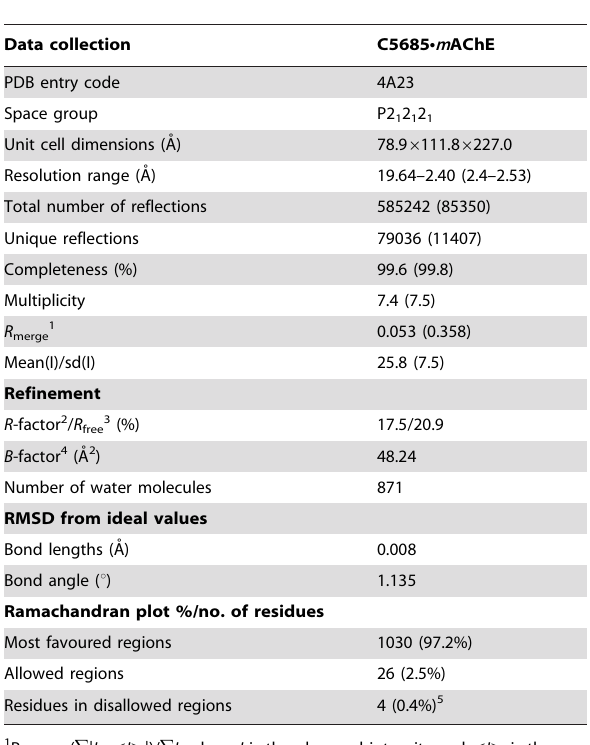
Table 4. Data collection parameters and refinement